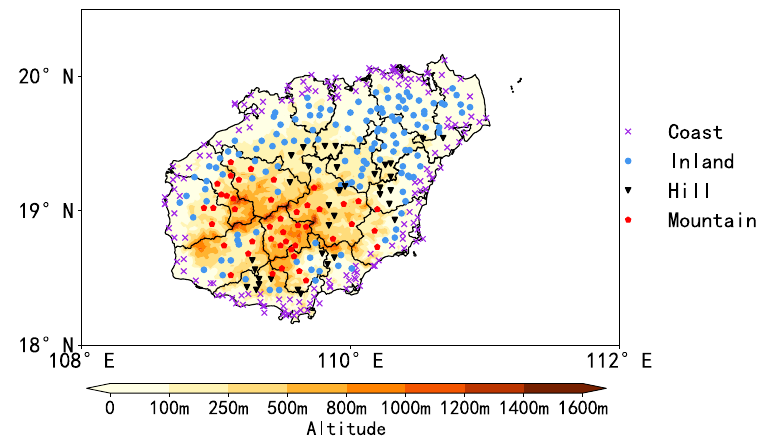
Figure 6. Distribution map of Hainan Island altitude and different landform stations.